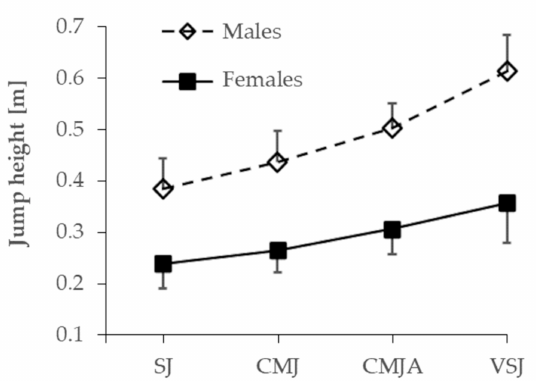
Figure 2. Mean and standard deviation of jump heights during SJ, CMJ, CMJA, and VSJ in females and